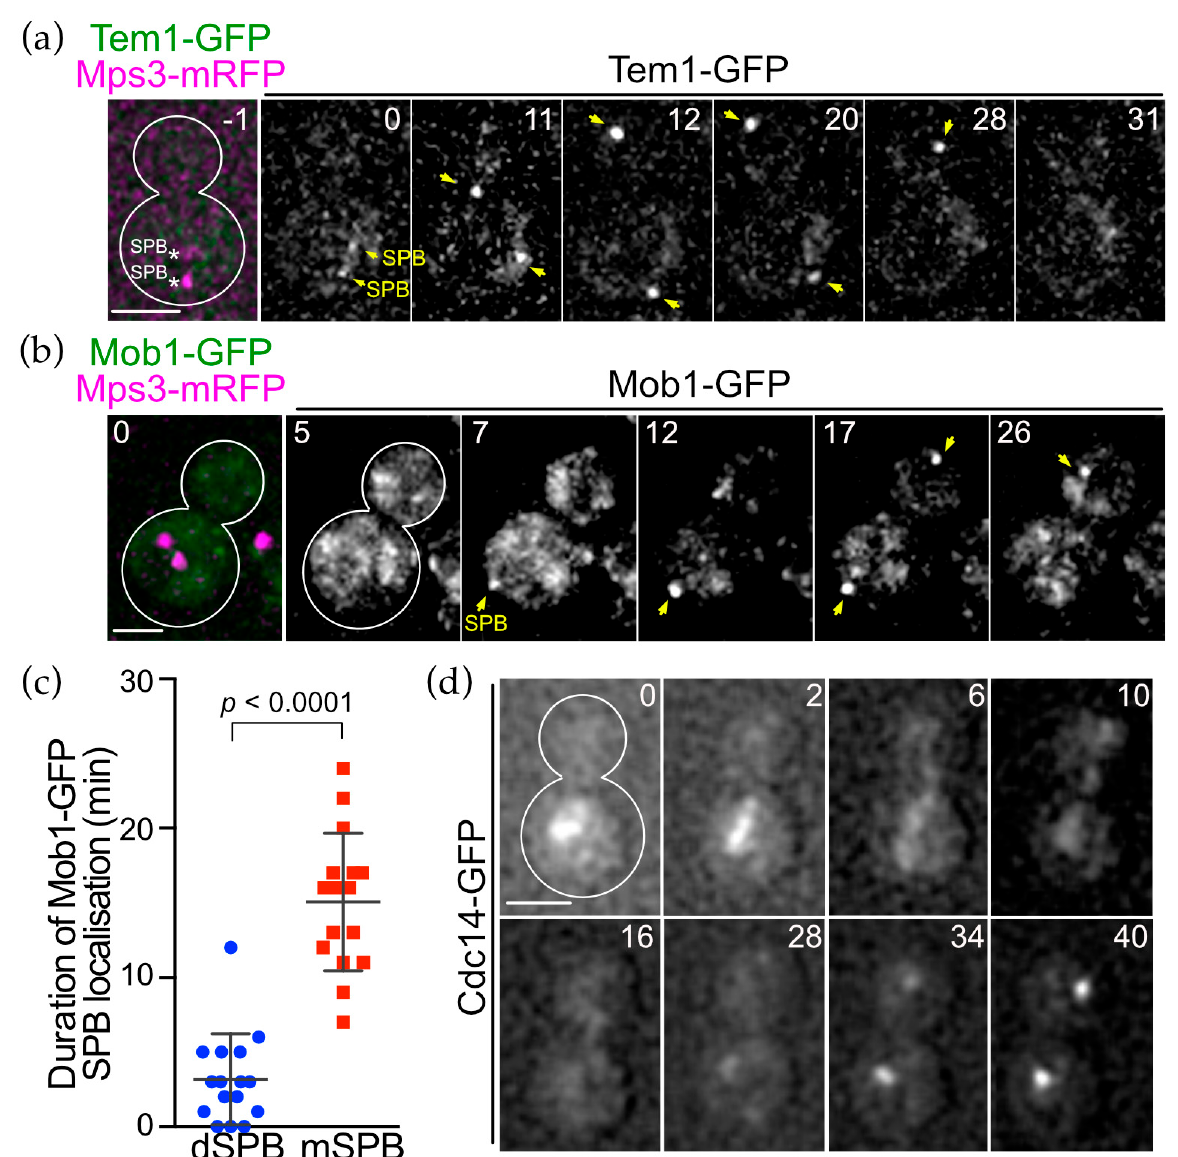
Figure 6. SPB association of OpTem1 and OpMob1 is cell cycle dependent. ( a ) Time-lapse microscopy of OpTEM1-GFP OpMPS3-mRFP cells (HPH1771). Images were taken every 1 min. The RFP image was only captured before the start of the time-lapse series. Anaphase onset was around the 12 min timepoint. The dSPB was inserted into the bud at the 15 min timepoint. Yellow arrows indicate SPBs. Scale bar, 2 µ m. ( b ) Time-lapse microscopy of OpMOB1-GFP OpMPS3-mRFP cells (HPH2108). Images were taken every 1 min. The RFP image was only captured at the first timepoint. The cell entered into anaphase before the 7 min timepoint. The dSPB was first detected at the 17 min timepoint. Yellow arrows indicate SPBs. Scale bar, 2 µ m. ( c ) Duration time of Mob1-GFP at the mSPB and dSPB was measured in the time-lapse experiment in ( b ). N = 16. Statistical significance was determined by the t -test. ( d ) Time-lapse microscopy of OpCDC14-GFP cells (HPH1479). Images were taken every 2 min. The cell entered into anaphase shortly before the 2 min timepoint. The anaphase nucleus was inserted into the bud before the 6 min timepoint. Scale bar, 2 µ